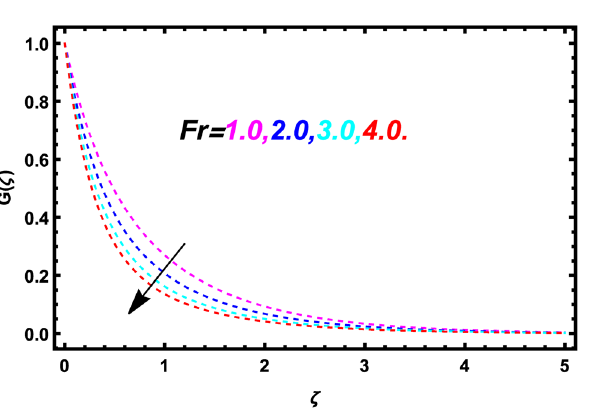
Figure 10. Demonstration of velocity curve versus Fr when k 1 = 0.1, k 2 = 0.3, M = 0.5, m = 0.2, Pr = 5.3, φ = 0.01, Ec = 0.3, ε Rd = 0.2, Sc = 0.1, ε Lb = 0.3, Pe = t = 3.0, C = 3.0, δ = 0.3,